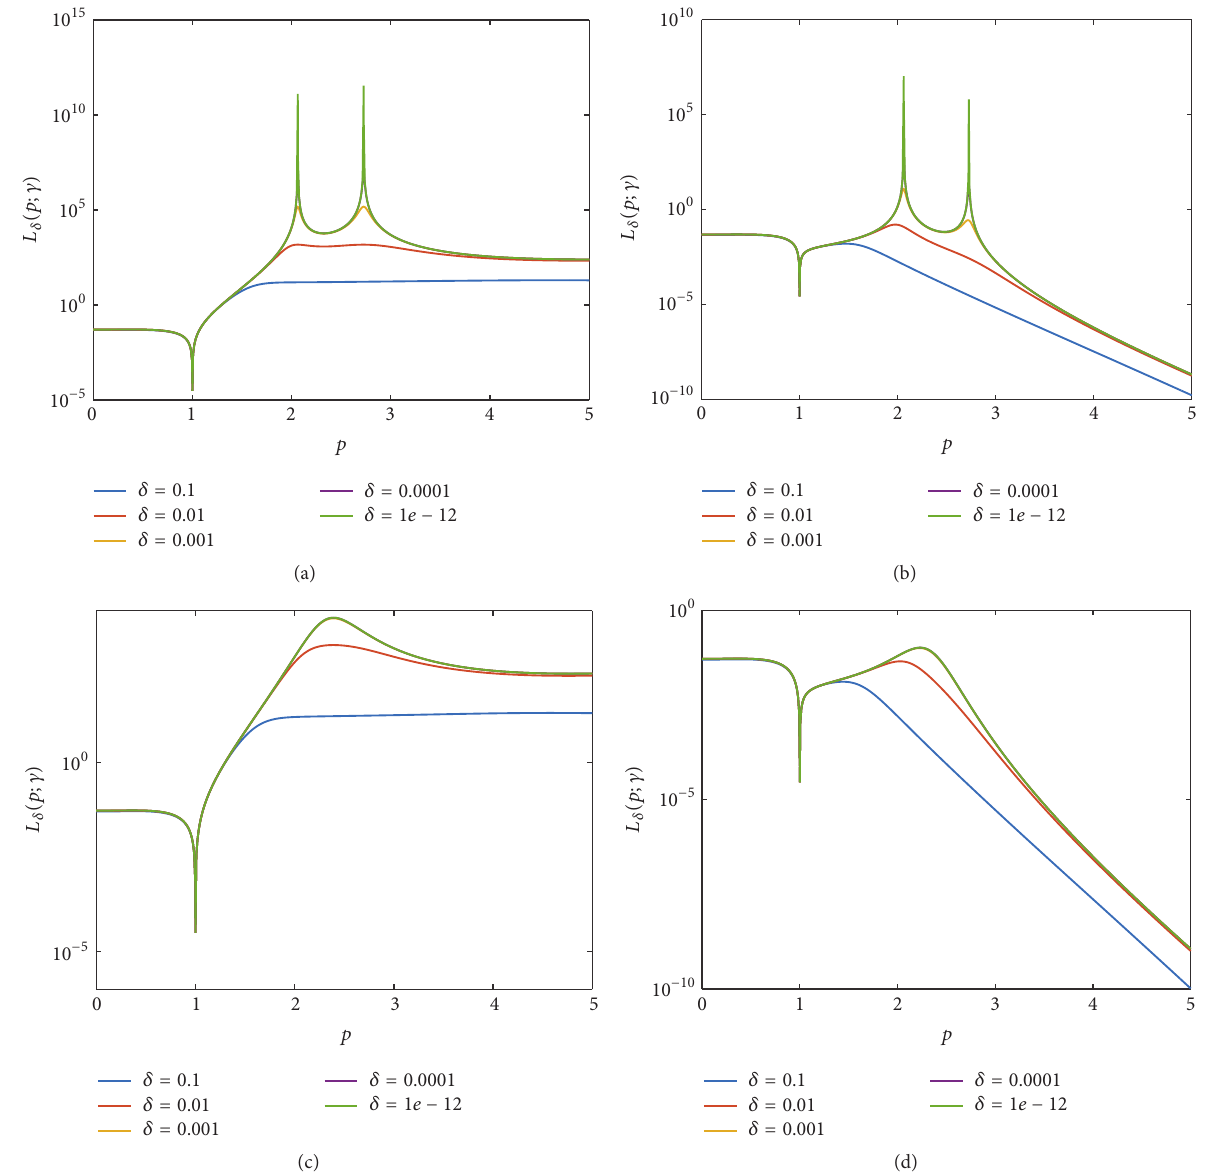
Figure 10: A plot of the integrand 𝐿 𝛿 (𝑝;𝛾) from (36) for several parameter values. The separate curves in each plot represent different values of 𝛿 , indicated in the legend: (a) 𝛾 = 0.99𝛾 ∗ and 𝑑 0 = 1.2𝑎 ; (b) 𝛾 = 0.99𝛾 ∗ and 𝑑 0 = 4𝑎 ; (c) 𝛾 = 1.01𝛾 ∗ and 𝑑 0 = 1.2𝑎 ; (d) 𝛾 = 1.01𝛾 ∗ and = 4𝑎 𝑑 0